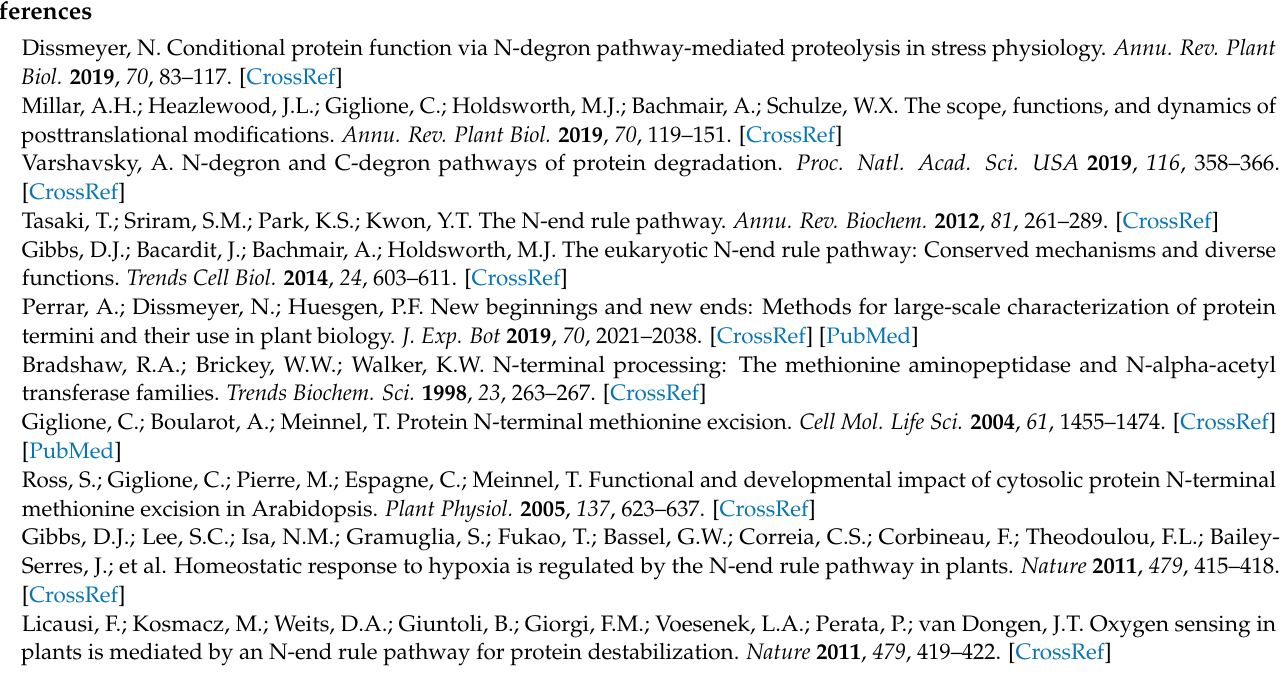
Figure design, corrections, and literature research. M.N. performed bioinformatics searches. All authors have read and agreed to the published version of the manuscript. Funding: This research was funded by the Austrian Science Fund FWF (grants P31114 and F7904-B to